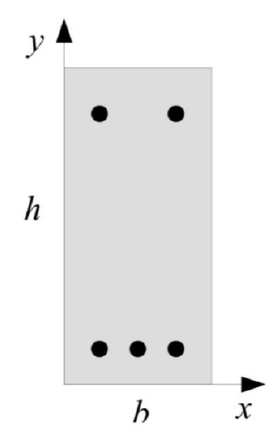
Figure 8. Rectangular cross